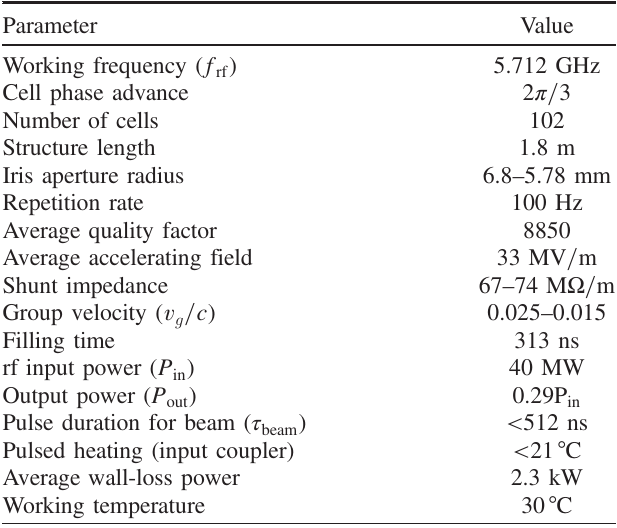
TABLE I. Main parameters of the ELI-NP accelerating